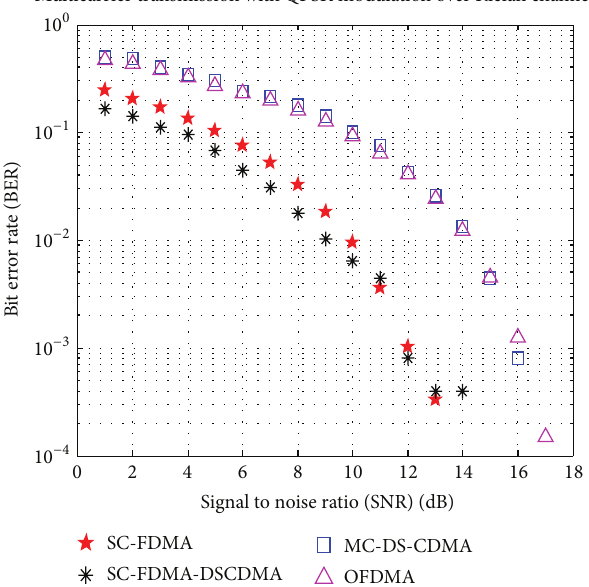
Figure 5: PAPR performance of the proposed SC-FDMA- DSCDMA technique for different FFT size with QPSK modulation. FFT size: 𝑁 indicates the number of subcarriers. PAPR increases with increase in FFT